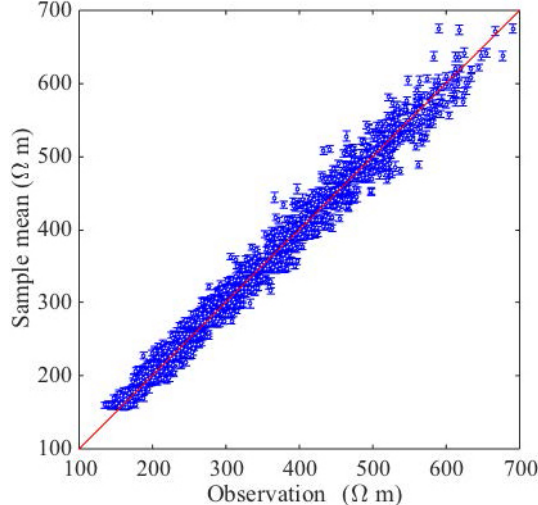
Figure 13. Comparison between estimated and synthetic thaw depth over a year for scenario 8. The blue and red lines, respectively, represent the synthetic and estimated thaw depth. The grey region shows the confidence interval with a level of 95%.